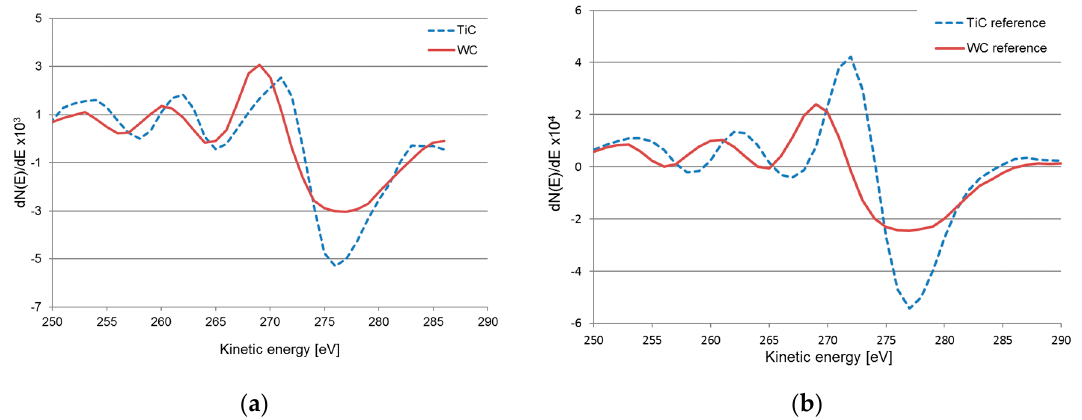
Figure 8. ( a ) Two different C KLL Auger spectra extracted from a carbon depth profile. C in WC (red spectra) and C in TiC (blue spectra), ( b ) carbon signals from reference samples of WC and TiC.